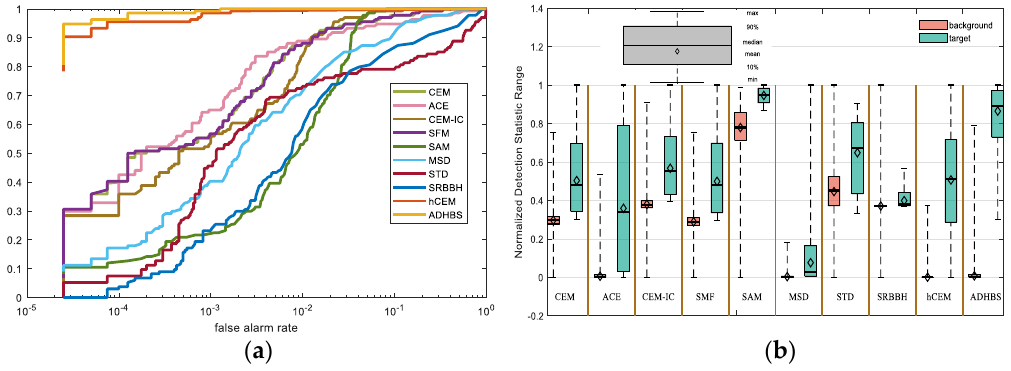
Figure 10. ( a ) The receiver operating characteristic (ROC) curve comparison for the San Diego airport data. ( b ) The separability map for the San Diego airport data.